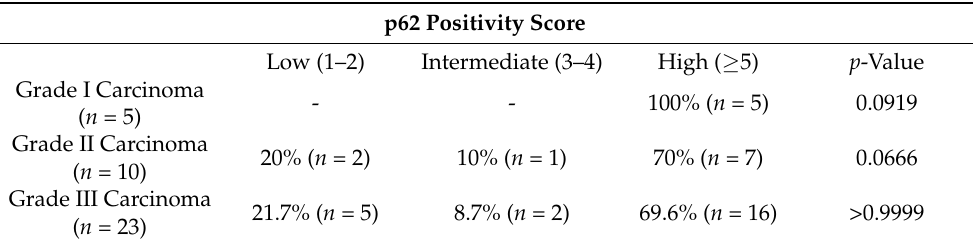
Table 1. Immunoreactivity score for p62 in the 38 cases of feline mammary carcinoma. Figure 1. p62 immunostaining in the non-neoplastic feline mammary gland and mammary